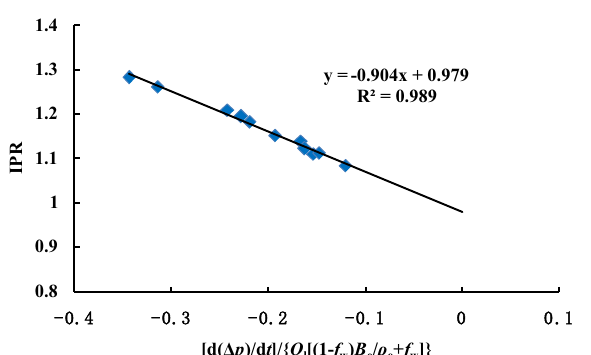
Fig. 1 Regression line between injection–production ratio data and d D p ð Þ = d